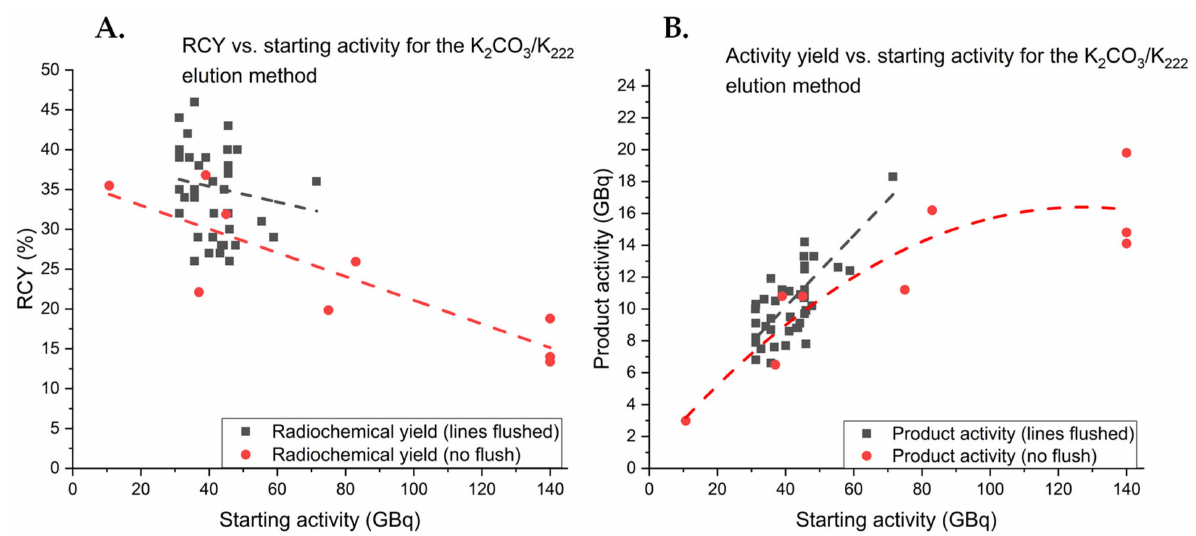
Figure 5. ( A ) Isolated RCYs of [ 18 F]FE-PE2I in relation to the starting activity of fluorine-18. ( B ) Comparison of the activity of isolated [ 18 F]FE-PE2I to the starting activity of